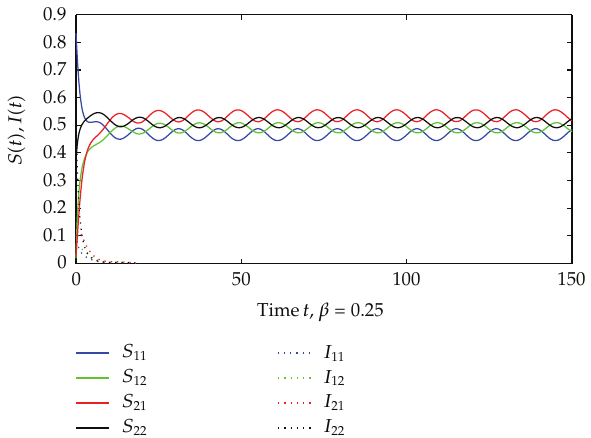
Figure 2: When R 0 < 1, a periodic disease-free solution exists and the disease dies